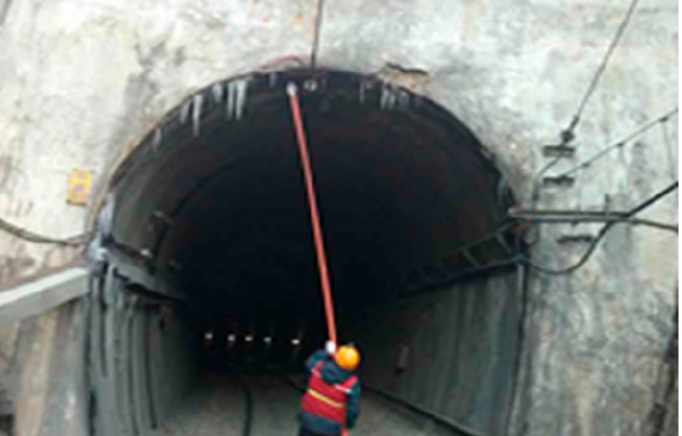
Figure 1. Icicle removal using manpower. Adapted with permission from Ref. [6]. Copyright 2021 by Korea Railroad Research Institute all rights reserved.